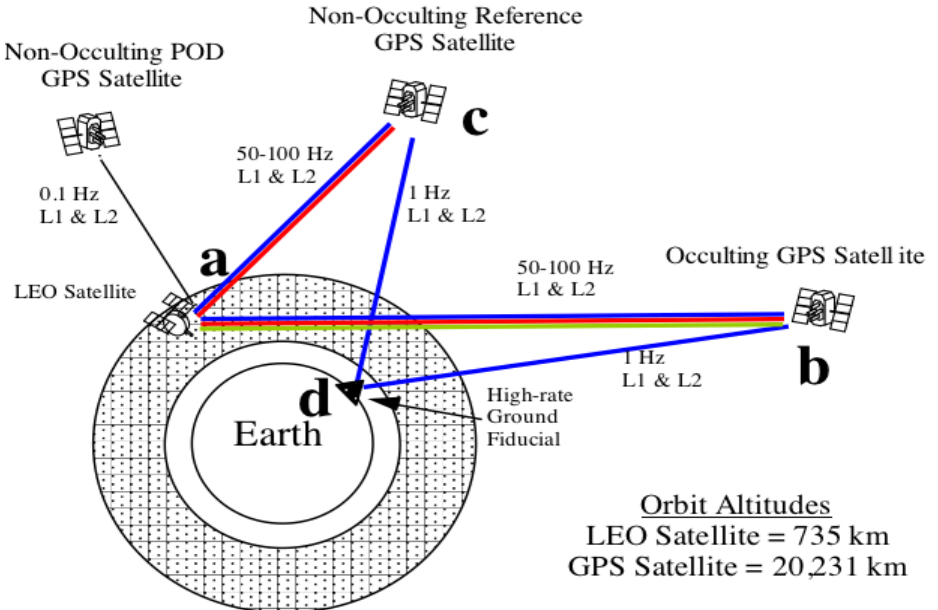
Fig. 1. Diagram of GPS RO observation geometry. Data links used for double differencing are shown in blue. Links for single-differencing are in red. Zero-differencing link shown in